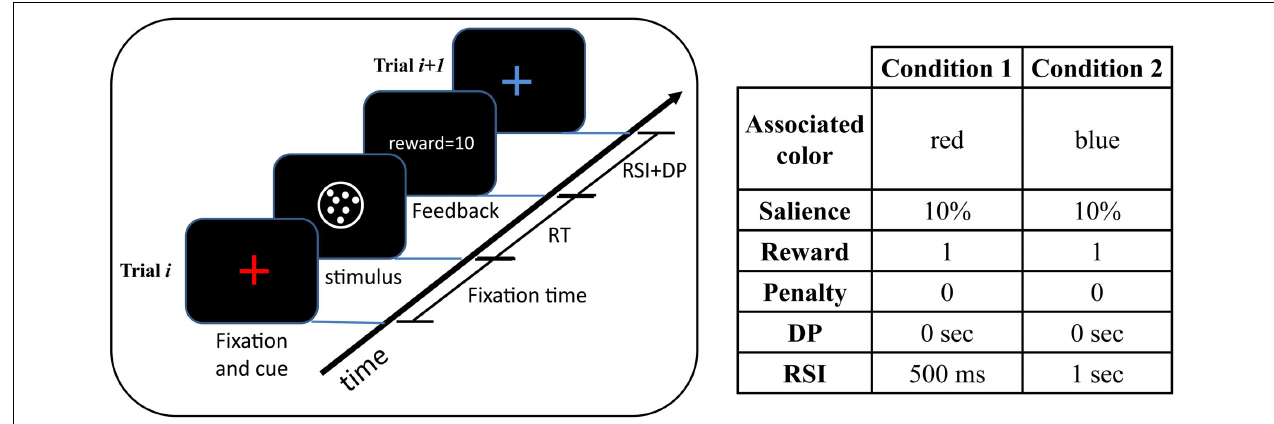
FIGURE 1 | An example of the experimental design. In this example, each trial can come from one of two conditions with equal probability. A colored cross-hairpresented atthebeginning ofeachtrialindicatestheconditionofthe upcoming trial. After the presentation of the cue, the stimulus appears and remains on the screen till the subject responds. After responding, the subject receives feedback. The time between subject’s response and the beginning of